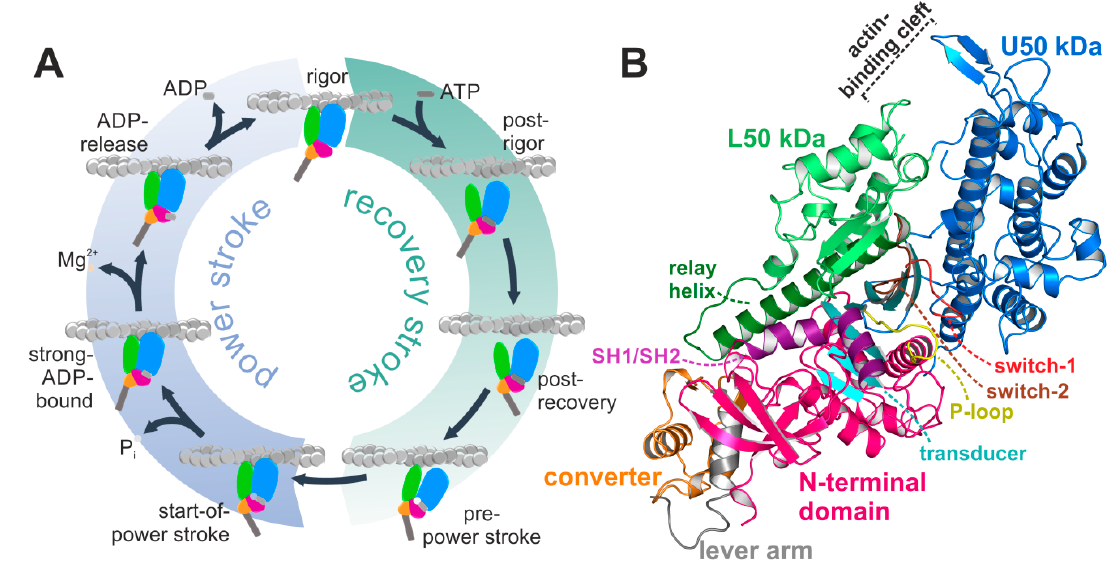
Figure 1. The actomyosin system. ( A ) Scheme of the actomyosin motor cycle. The myosin motor is subject to conformational changes of the subdomains upon interaction with both the actin filament and the nucleotide adenosine triphosphate (ATP), as well as during nucleotide hydrolysis, and release of its hydrolysis products inorganic phosphate (P i ) and adenosine diphosphate (ADP) to eventually produce force in a two-step mechanism. Color code: subdomains N-terminal domain (pink), U50 kDa (blue), L50 kDa (green), converter (orange), lever arm (grey). ( B ) Structure of the nucleotide-free Dd myosin-II motor domain, possessing a closed actin-binding cleft, a twisted transducer (cyan), and the converter (orange) / lever arm (grey) in the down position. The active site with the nucleotide sensors P-loop (yellow), switch-1 (red), and switch-2 (brown) is empty and prepared for ATP binding.